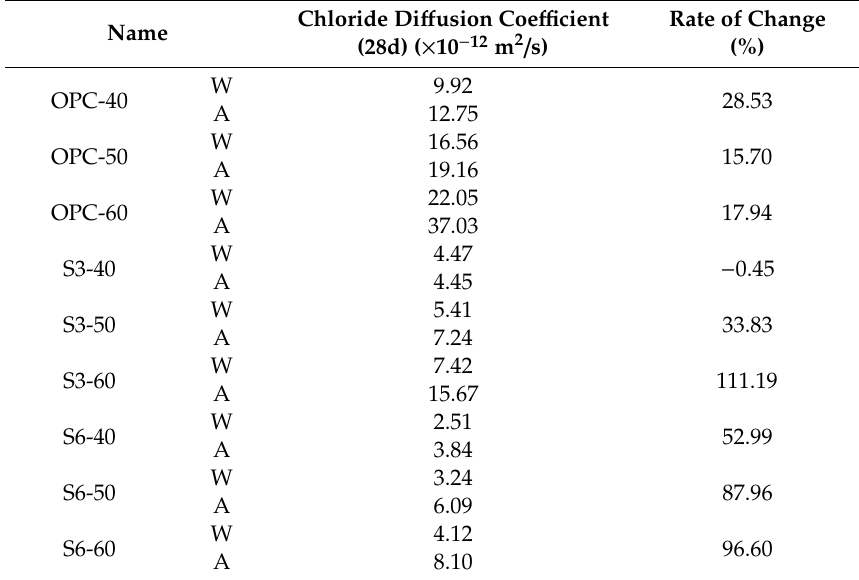
Table 6. Result of Chloride di ff usion coe ffi cient of concrete according to curing